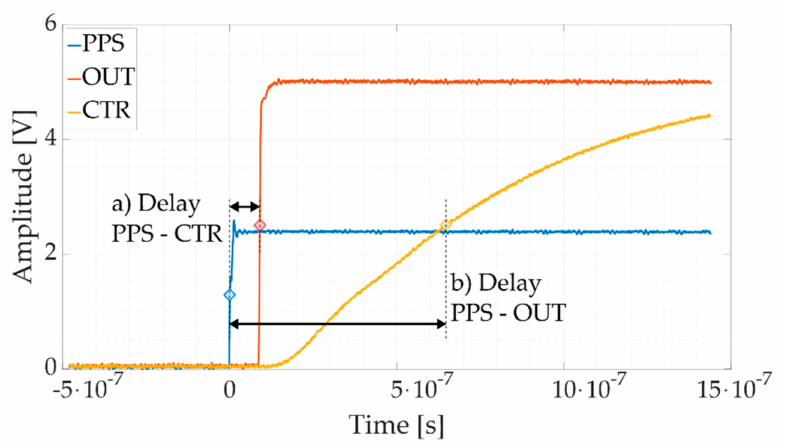
Figure 5. Oscilloscope waveform acquisitions for the board synchronization evaluation. The PPS signal ( blue ), the CTR signal ( red ), the OUT signal ( yellow